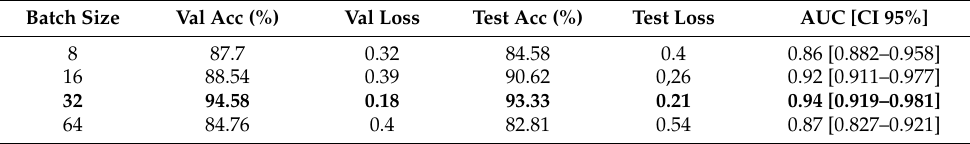
Table 2. Comparison of various batch